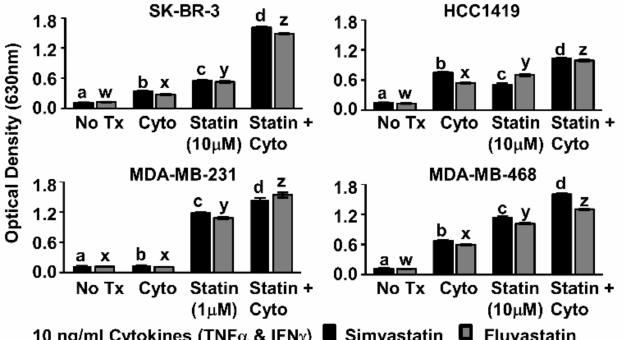
Figure 2. Combination of Th1 cytokines and statin drugs potentiates metabolic suppression in breast cancer lines. SK-BR-3, HCC1419, MDA-MB-231, and MDA-MB-468 human breast cancer cell lines were cultured with no additives (No Tx), treated with recombinant Th1 cytokines (“Cyto” TNF- α and IFN- γ , 10 ng / mL each), statin drugs (Simvastatin or Fluvastatin, 1 µ M MDA-MB-231; 10 µ M remaining cell lines), or the combination of Th1 cytokines and a statin drug (“Statin + Cyto”). After 72h incubation, Alamar Blue dye was added and, following color change, optical density of culture supernatants was determined. Results displayed are from one representative experiment of at least four trials +/ − Standard Error of the Mean (SEM). Letter designations represent Tukey’s Honest Significant Di ff erence (HSD) comparisons: treatments with the same letter designation are not statistically di ff erent; when letter designations di ff er between treatments, the p-value is less than 0.05.